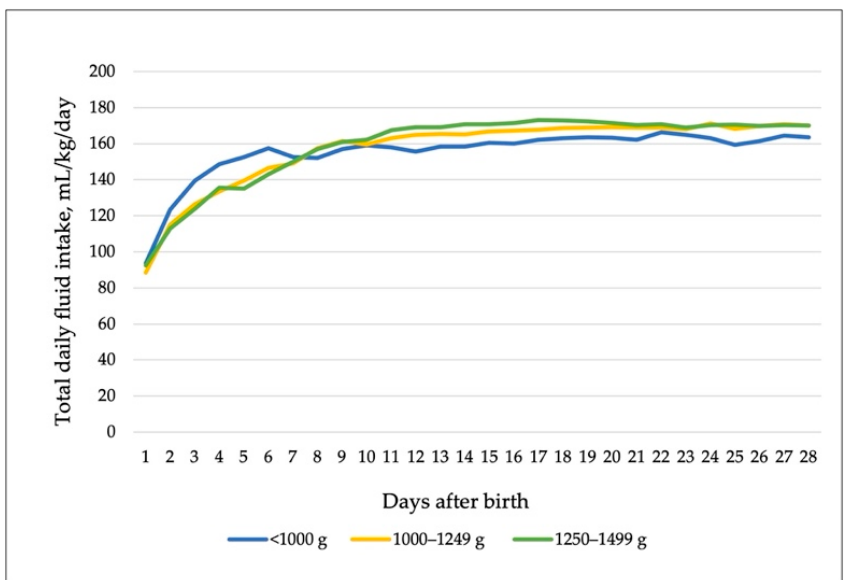
Figure 1. Total daily fluid (parenteral and enteral) intake in different birth-weight groups. Data are medians.